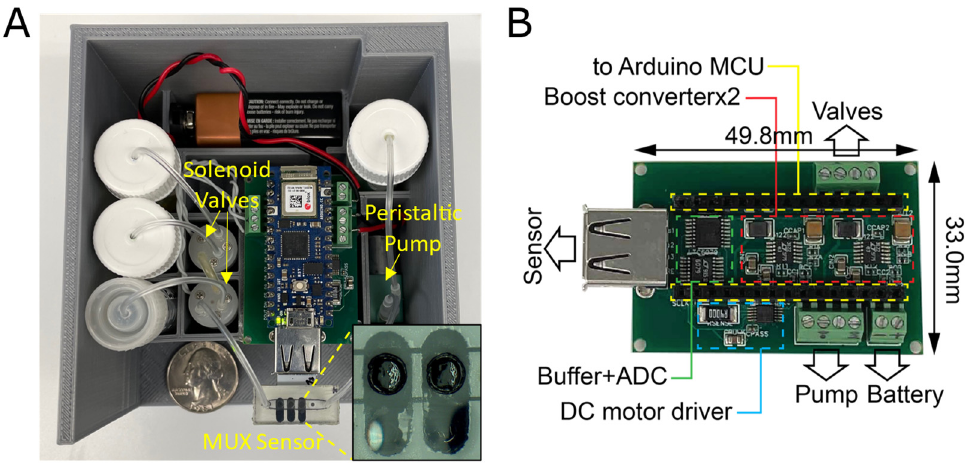
Figure 2. Integrated SCISE sensor system for long-term, in situ measurements: ( A ) Photograph of the fully assembled system. The Arduino board was connected to the custom PCB by stacking. ( B ) Photograph of the custom PCB circuit showing the layout of functional